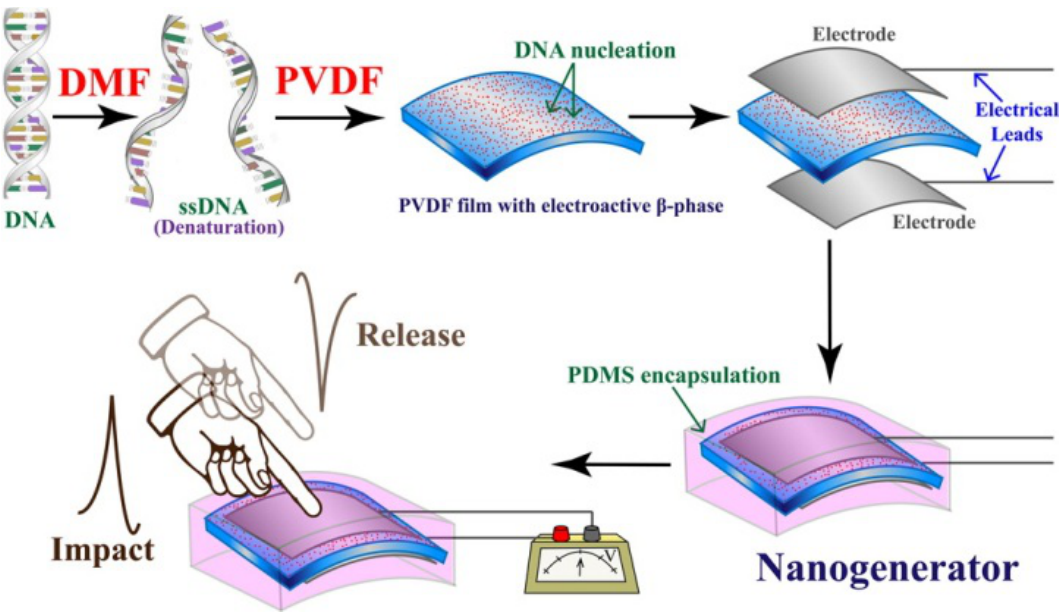
Figure 15. The structure of a flexible nanogenerator for Portable Electronic Devices [178].